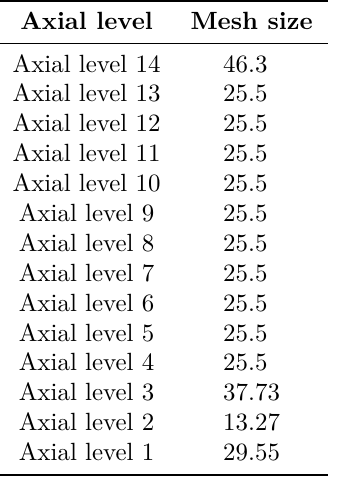
Table 4. TRACE axial